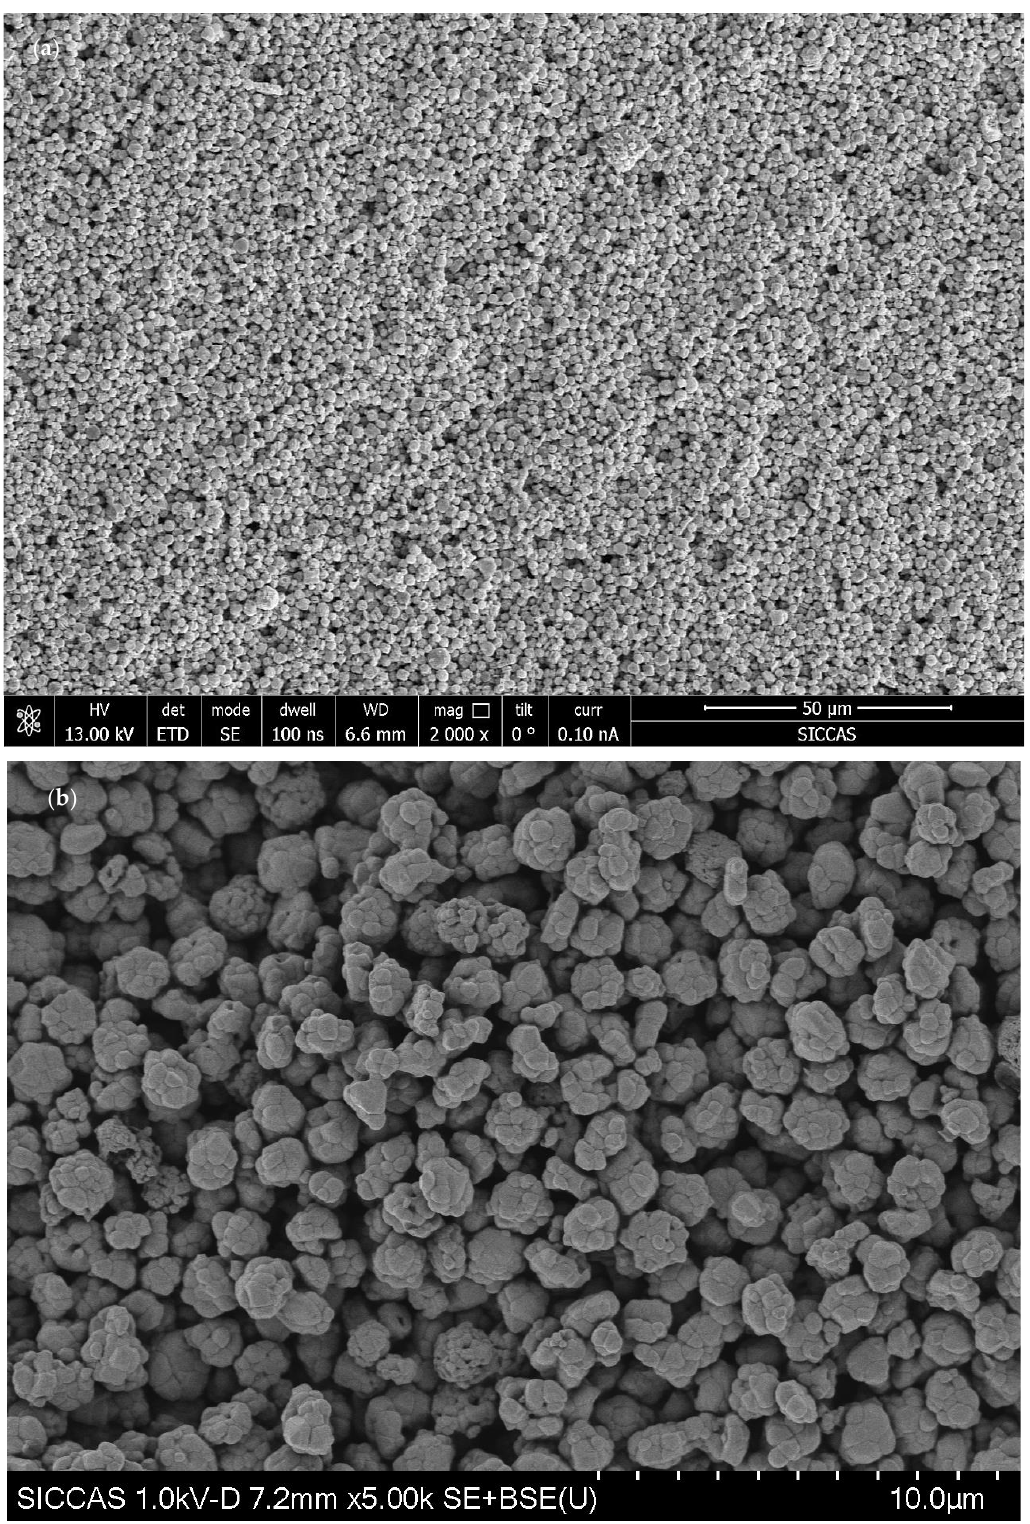
Figure 9. ( a ) The controlled synthesis of AB 2 O 4 -type CoFe 2 O 4 micro/nanostructures by modified polyol methods [56]. ( b ) CoFe 2 O 4 micro/nanostructures with heat treatment at high temperature in a range of 900 – 1100 °C (SEM data in our new experimental). It is clear that Pt nanoparticles can be potentially integrated in a ferrite matrix of CoFe 2 O 4 for electrocatalysis.